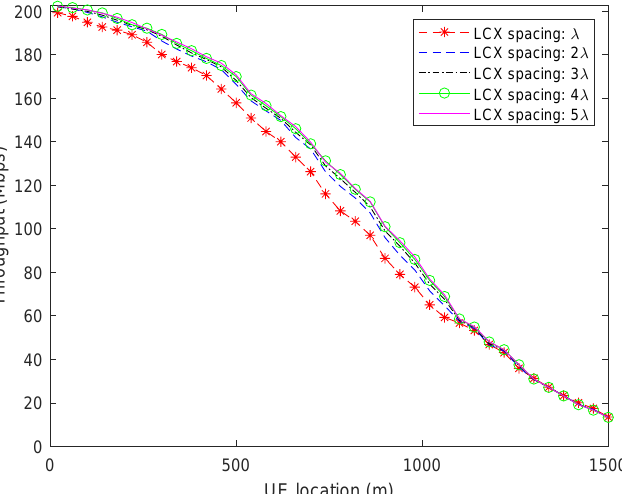
Figure 9. The effect of the LCX spacing interval on the throughput—4T4R (LCXs on both